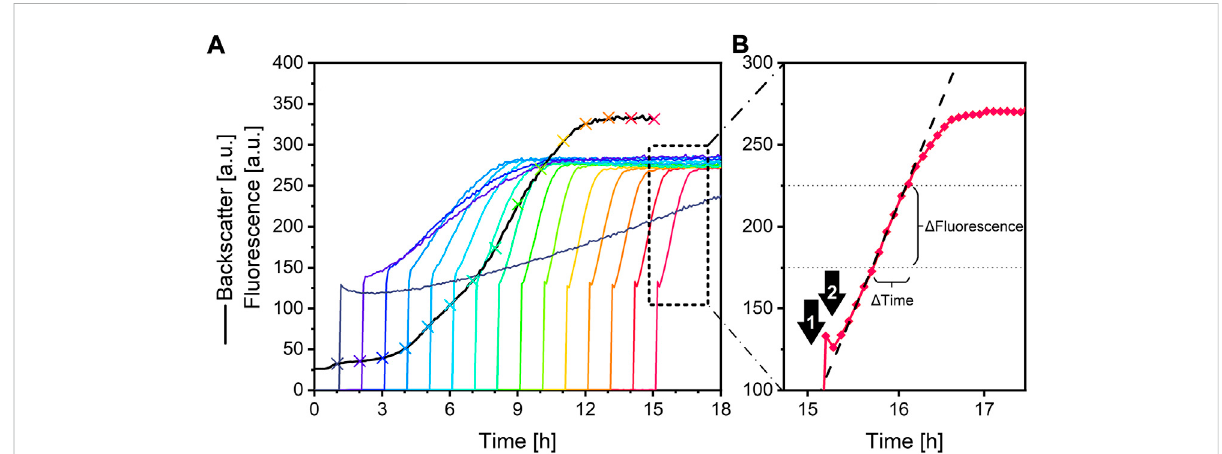
FIGURE 4 (A) Backscatter (black line) and fl uorescence data (multicoloured lines) from a microplate cultivation of S. pasteurii with automated sampling and urease activity measurement. The crosses, coloured to their according fl uorescence signal, indicate culture sampling. (B) Fluorescence curve (red diamonds) after sample addition for urease activity measurement. The arrows are indicating the measurement points (1) after the fl uorescein reagentisaddedtothewell,and(2)aftertheureolyticsampleisaddedtowell.Theblackdashedlineindicatesthelinear fi tofthesignalbetween 175 a. u. and 225 a. u. Culture conditions: 48-well Flower Well Plate, culture fi lling volume 1,200 μ L, reagent fi lling volume 1,000 μ L, shaking frequency 1,200 rpm, shaking diameter 3 mm and temperature 30 °